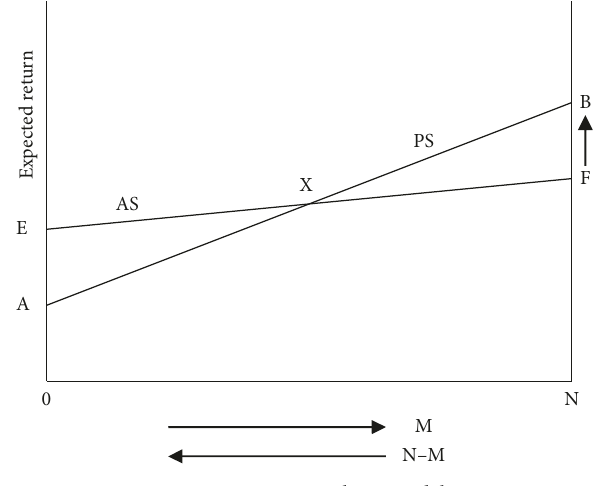
Figure 3: Viscous slope